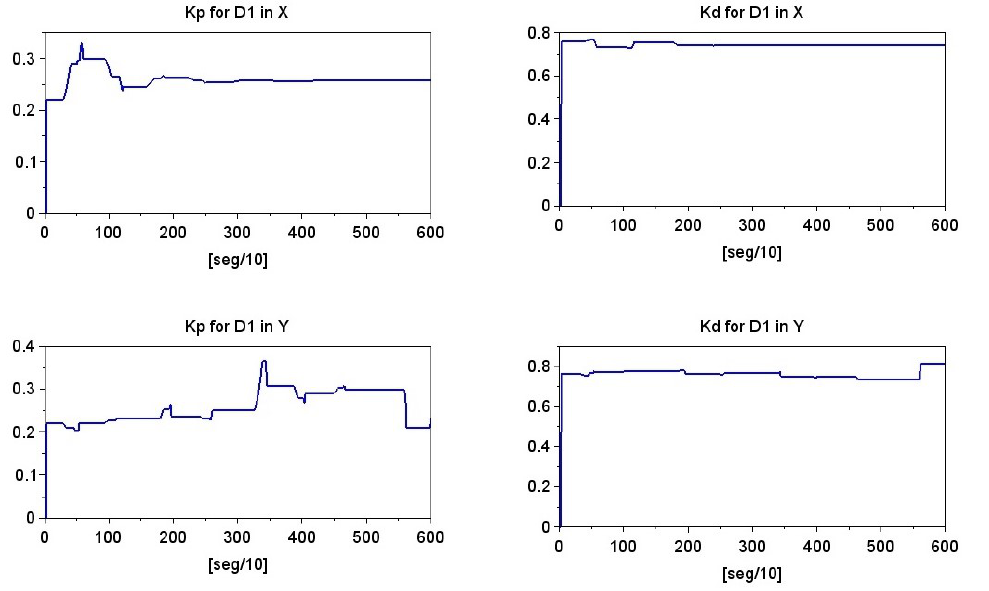
Figure 13. Instantaneous values of the AFM online-tuned parameters of the PD controller of D 1 along both X and Y axes.